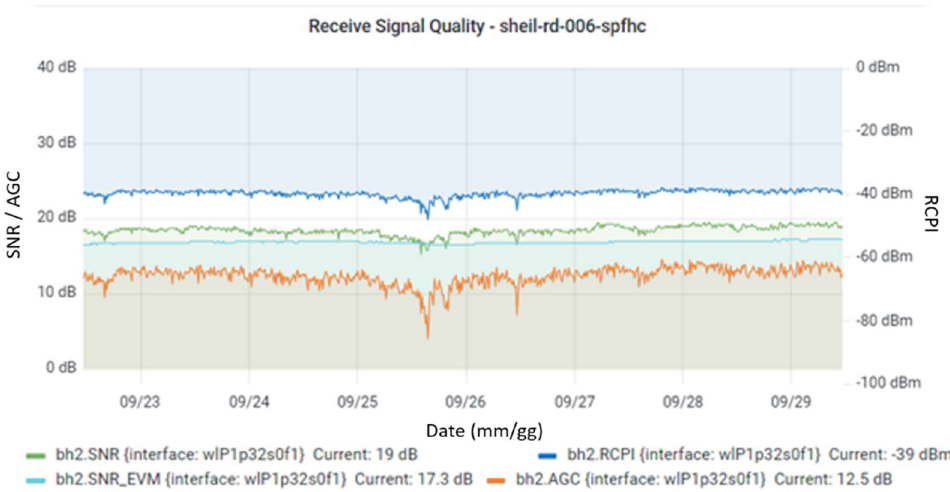
Figure 10. Performance in terms of SNR of Link 3.